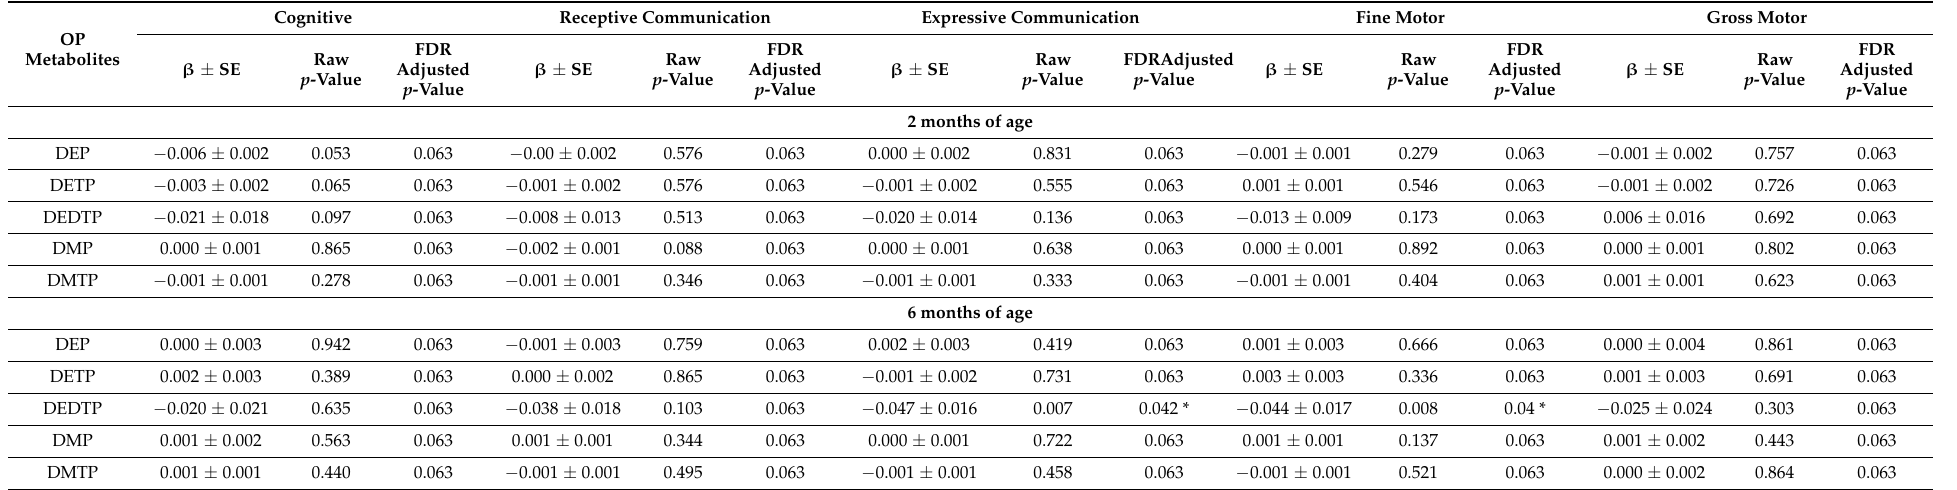
Table 6. Association between maternal urinary OP metabolites in the 3rd trimester and infant developmental screening scores using the Bayley III screening test at 2 and 6 months of age. Cognitive Receptive Communication Expressive Communication Fine Motor Gross OP Metabolites